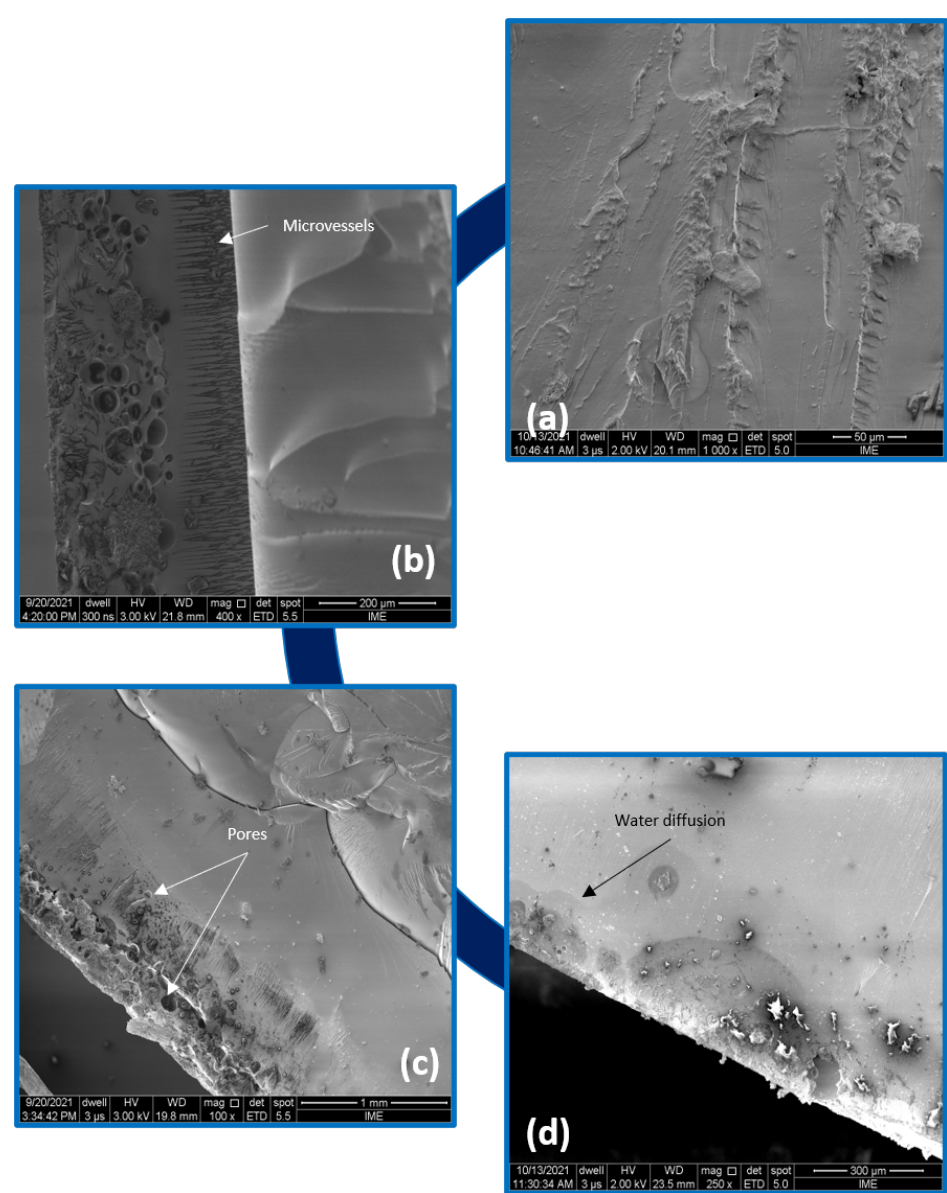
Figure 6. SEM microscopy appearance of the epoxy: control group ( a ) and water immersion aged after 240 h ( b ), 720 h ( c ) and 1440 h ( d